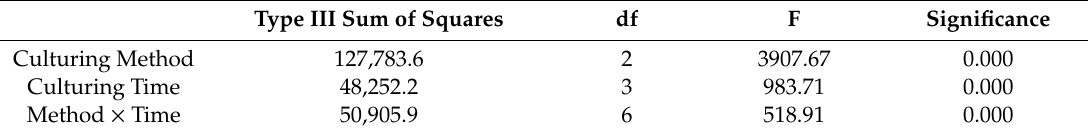
Table 2. Results of two-way analysis of variance of CCK-8.